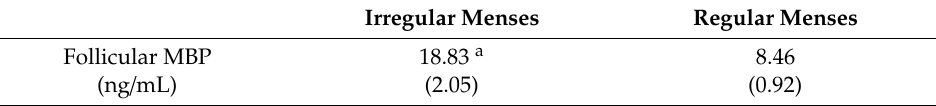
Table 6. BMI adjusted follicular MBP concentration means and standard error (in brackets). Irregular Menses Regular